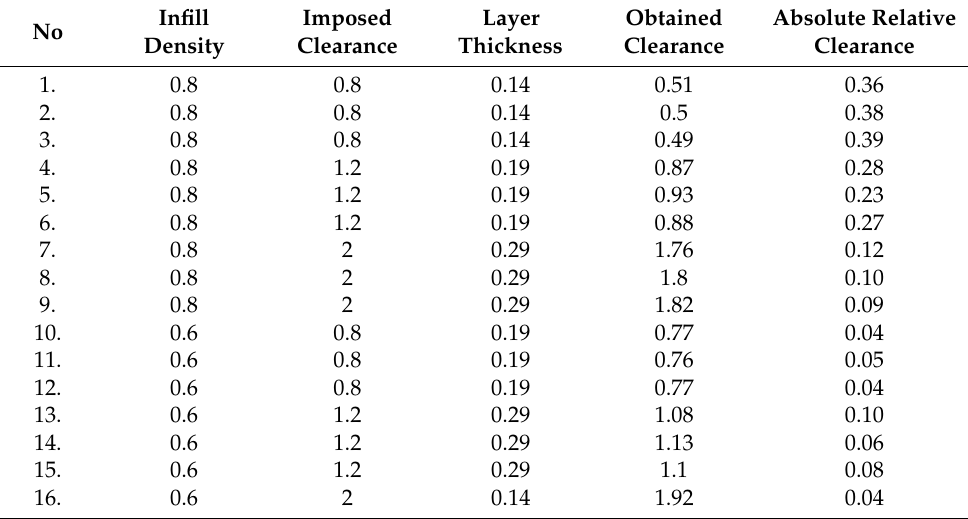
Table 3. The dataset for the experiment.